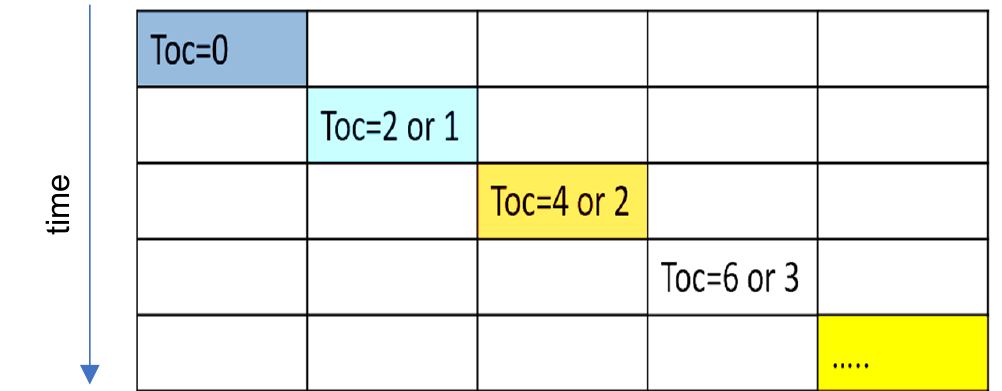
Figure 10. Structure of the partial derivative matrix H of the pre-fit discrepancies relative to the arc parameters. The arc parameters are indexed with the time Toc (Toe is equivalent) and the nominal values are dependent on the individual arcs being 2 h or 1 h long.